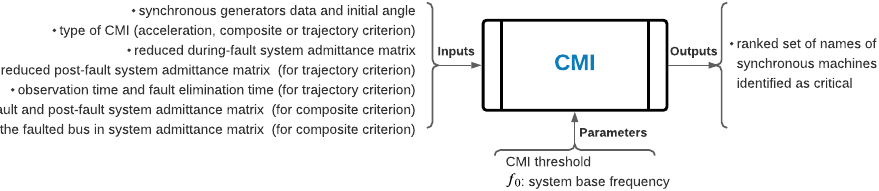
Figure 12. Schematic representation of CMI function to find the ranked list of critical synchronous generators.